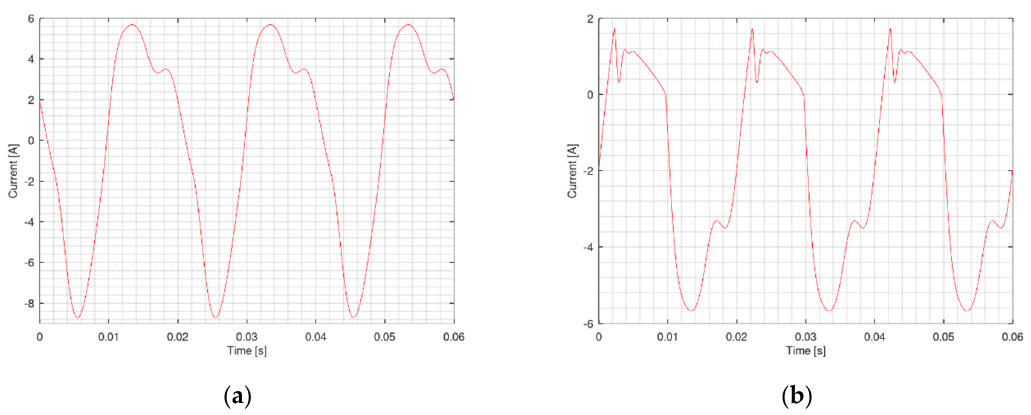
Figure 10. Current through: ( a ) the generator in the time domain; ( b ) inductance 𝐿 (cid:2869) in the time domain.